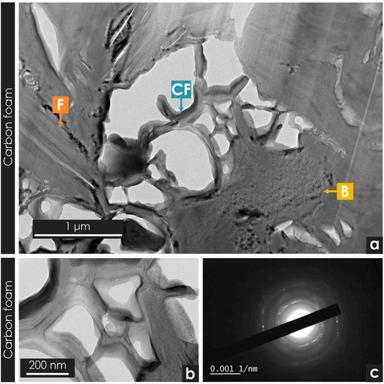
TEM bright-field micrographs of CGB graphite. (a) General microstructure of CGB graphite, (b) carbon foam, and (c) SAED pattern of carbon foam.